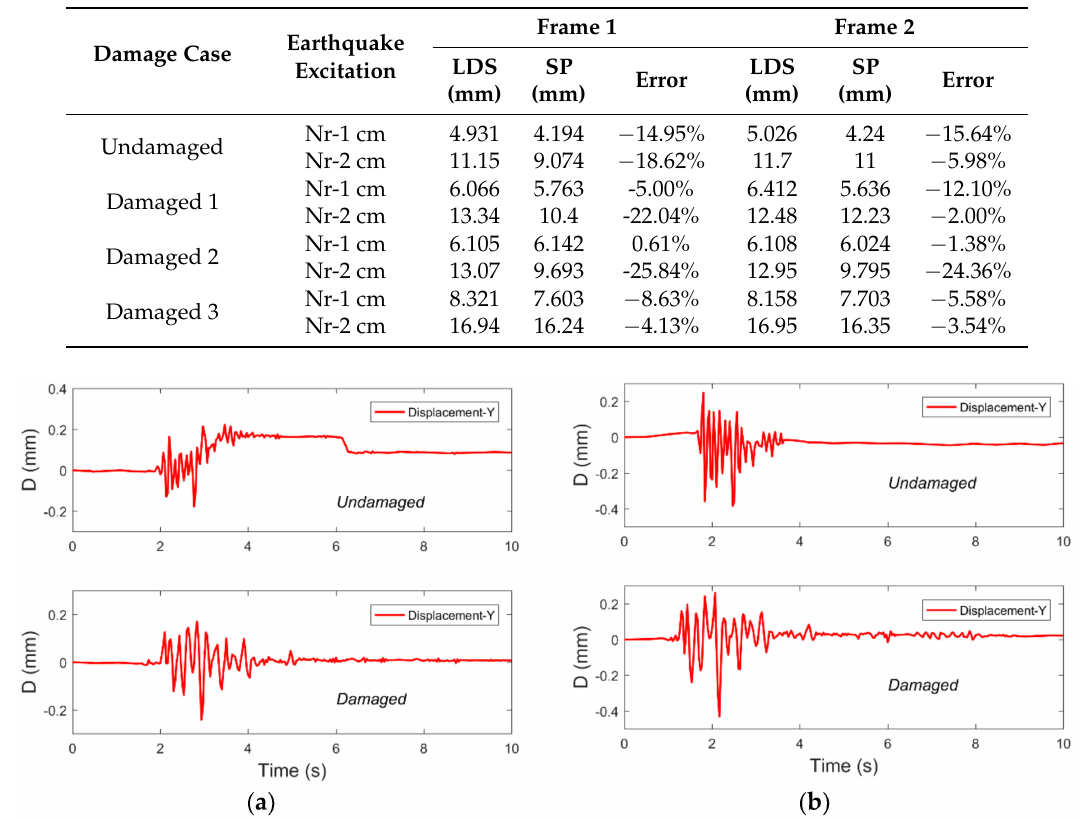
Figure 8. Displacement of the frame in the Y direction for ( a ) the Northridge-1 cm case and ( b ) the Northridge-2 cm